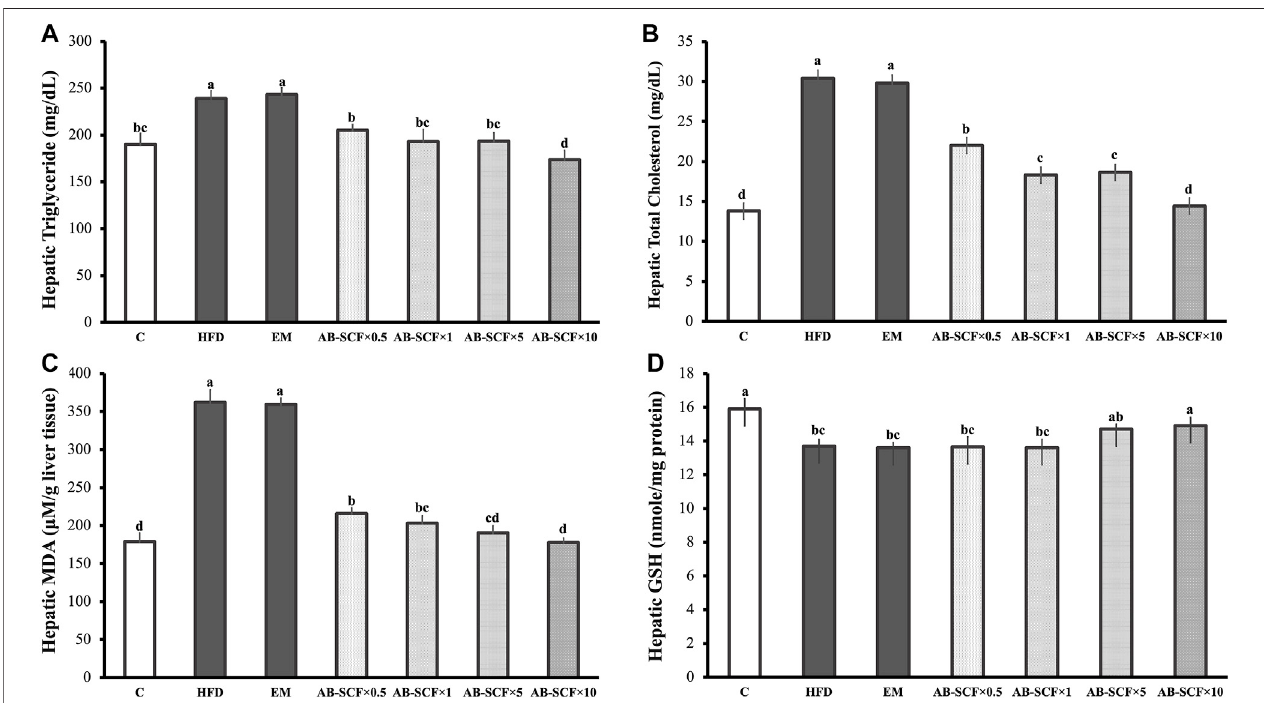
FIGURE 2 | Effects of AB-SCF on the lipid accumulation and oxidative stresses in liver. (A) Levels of hepatic triglyceride; (B) Levels of hepatic total cholesterol; (C) Levels of hepatic MDA (malondialdehyde); (D) Levels of hepatic GSH (glutathione) in normal, HFD induced and AB-SCF administrated hyperlipidemia hamsters. HFD, high-fat diet; EM, Tween 80/Span 80 (cid:2) 5:1 v/v, diluted water to 5%; AB-SCF, supercritical fl uid extracted aldlay bran. C, a blank control group fed with standard chow dietandwater;HFD,ahighfatdietinducedhyperlipidemicgroupfedwithwater;EM,ahighfatdietinducedfedwiththeemulsi fi erofAB-SCF;Experimentalgroups were induced with HFD and administrated AB-SCF/emulsi fi er with a dose-ascending manner, i.e., AB-SCF × 0.5, 30.84 mg/kg/BW; AB-SCF × 1, 61.67 mg/kg/BW; AB- SCF × 5,308.35 mg/kg/BW;AB-SCF × 10,616.70 mg/kg/BW.Dataaremean ± SD, n (cid:2) 10hamstersineachgroup.Meanswithdifferentlettersinthesamecolumnwere signi fi cantly different at p < 0.05 as statistically analyzed by Duncan ’ s multiple range